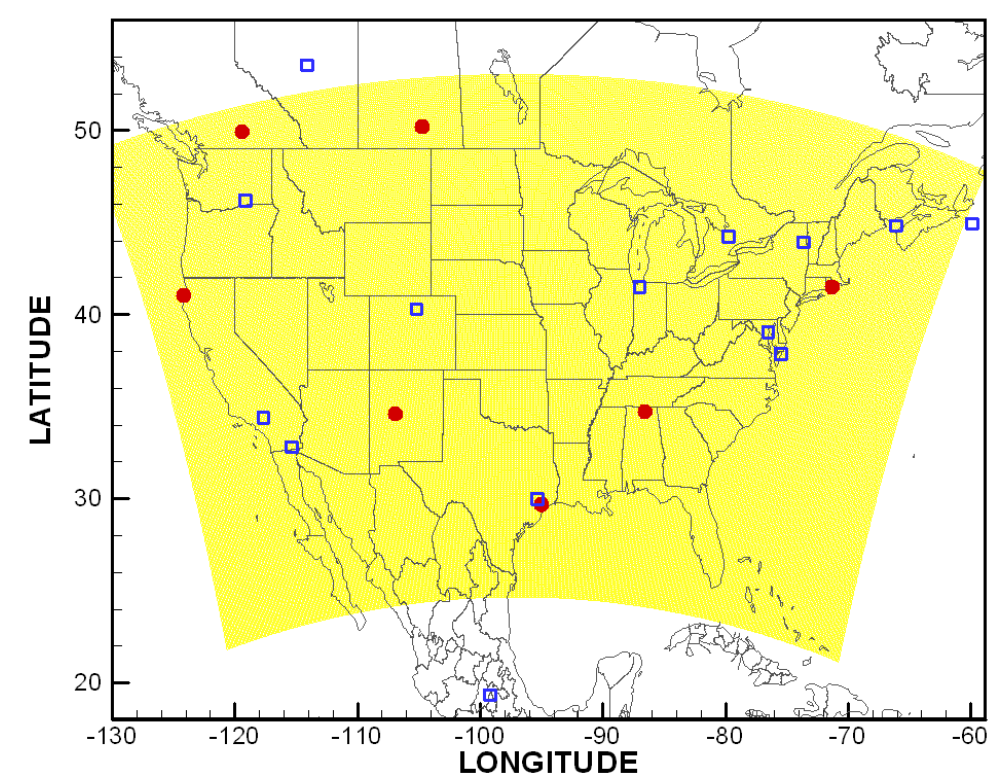
Figure 1. CMAQ CONUS computational domain and ozonesonde locations. Red circles indicate ozonesonde locations where observations are used to calculate vertical model error statistics. Unit of longitude and latitude: